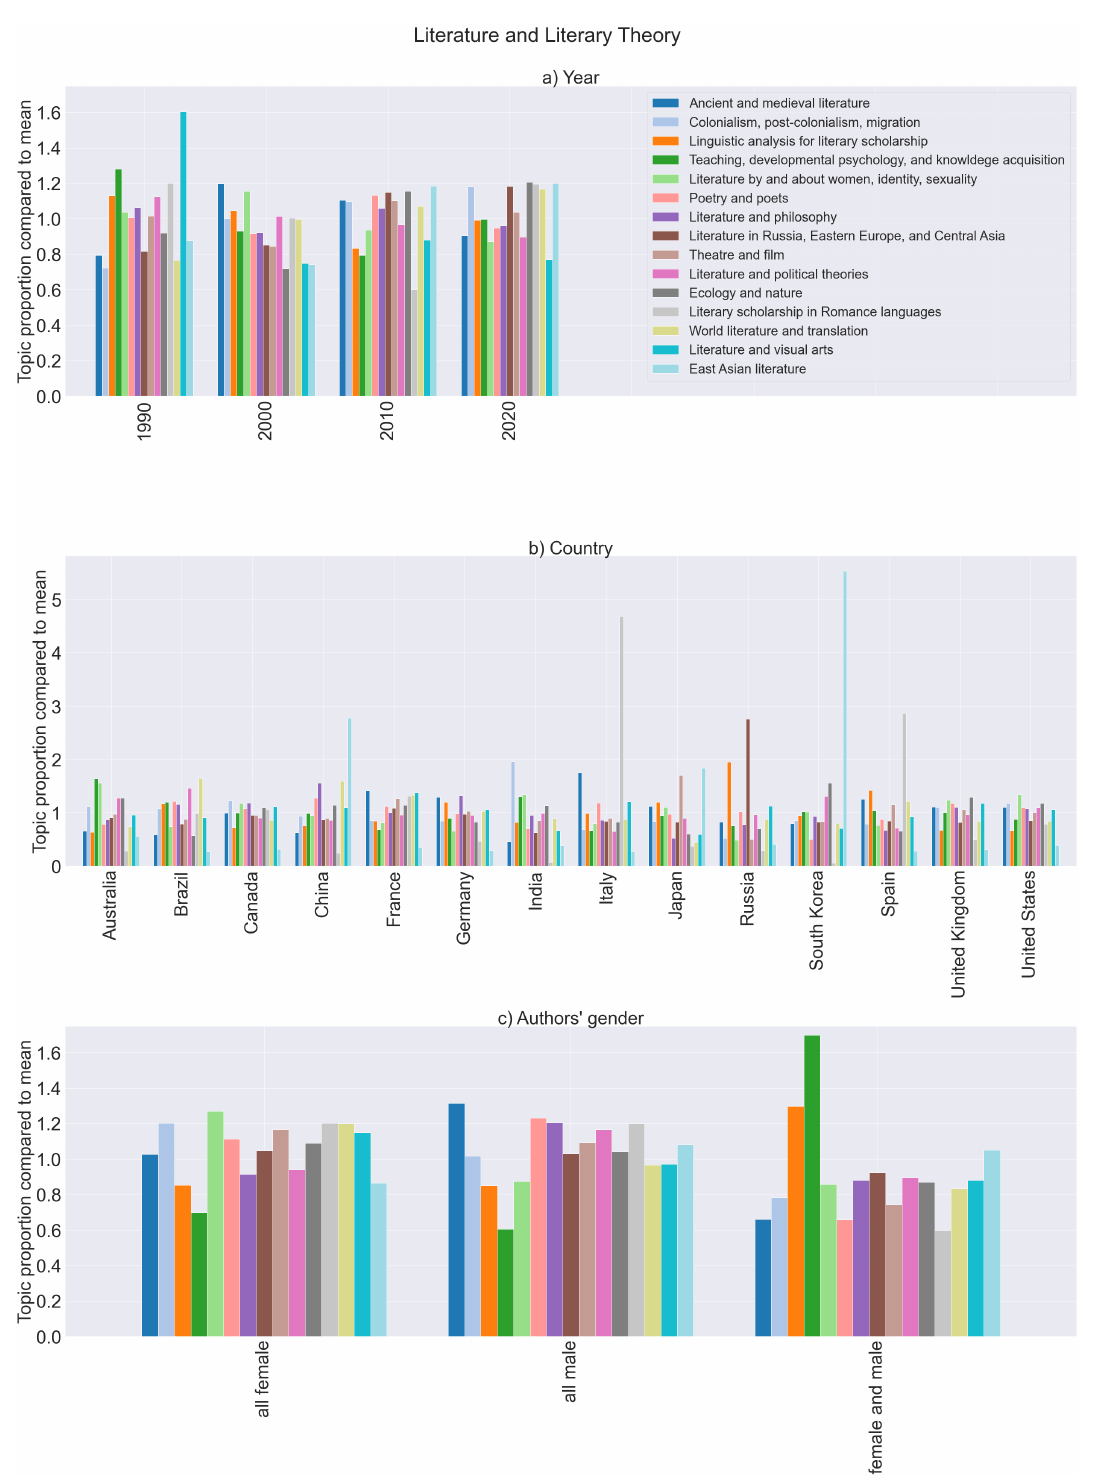
Figure 5. Topic proportion compared to mean, c κ ( ˆ D α ) , for 15 topics of the sub-area literature and literary theory grouped by ( a ) publication year, ( b ) country, and ( c ) authors’ gender. The legend for the topics and their colour codes at the top right corner applies to all three